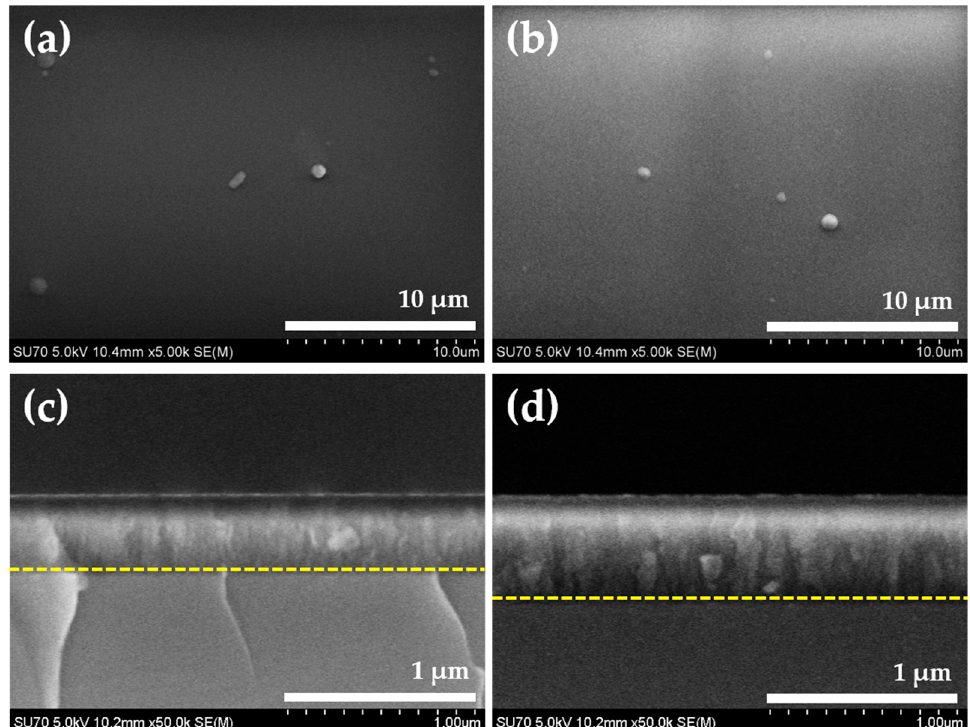
Figure 7. ( a ) Top and ( c ) cross section views of FESEM images of the silicon oxide film deposited on the Si substrate using the quartz tube without the nozzle with preheated N 2 at 5000 sccm with ( b ) top and ( d ) cross section views of those at 15,000 sccm.